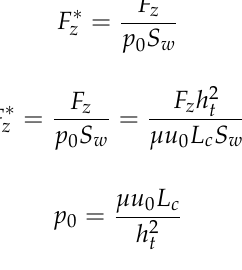
Mass density of lubricant, ρ liquid (kg/m 3 ) 833 Kinematic viscosity of lubricant, ν lub (mm 2 /s) 433 Sliding speed, υ w (mm/s) 20 Flow velocity, υ f (mm/s) 20 Lubricant film thickness, h t ( µ m) 2 Atmosphere temperature, T (K) 293.15 Contact angle of dropped lubricant on polished die, θ ( ◦ )